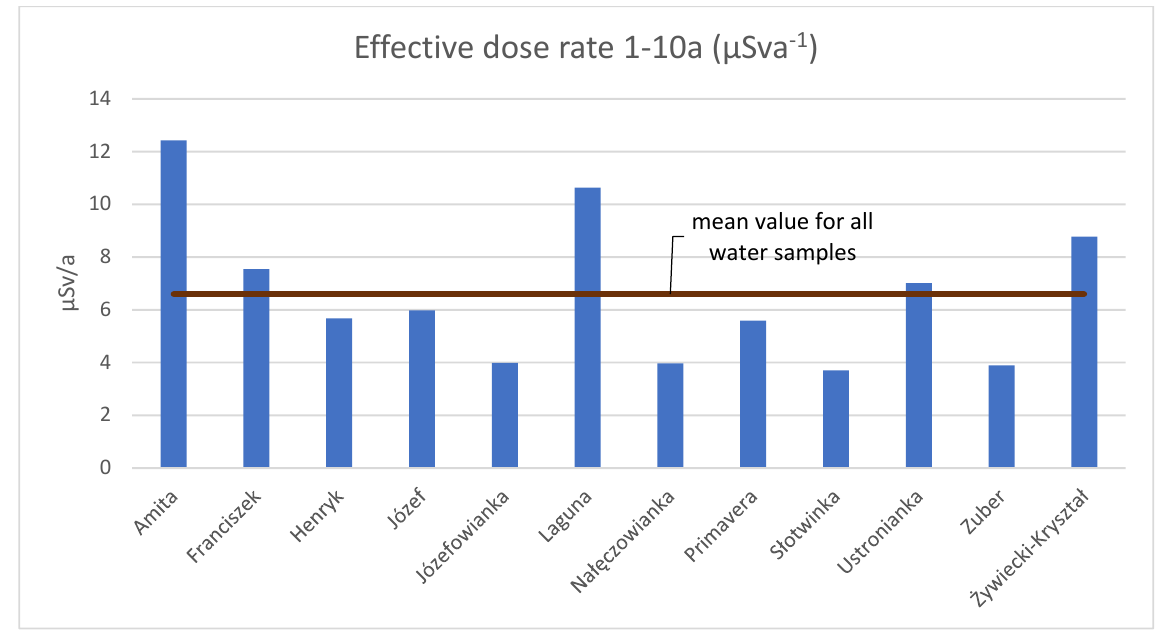
Figure 4. Annual effective dose for children from 1 to 10 years of age from the consumption of indi- vidual mineral waters.